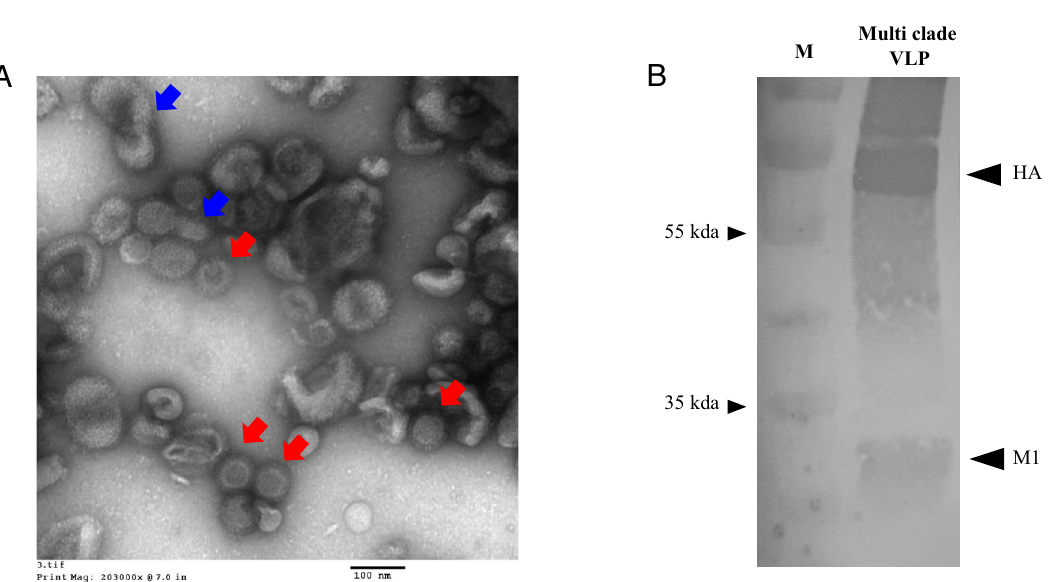
Figure 1. Transmission electron microscopy (EM) and Western blot analysis of multi-clade VLPs. Negative stain (1% uranyl acetate) EM image of multi-clade VLPs (Scale bar is 100 nm, red arrow indicates multi-clade VLP and blue arrow indicate baculoviral particle) ( A ). Blots were incubated with chicken anti-HA antiserum and goat ant-chicken IgG (HRP). HA and M specific bands were detected in preparations of multi clade VLP infected cells ( B